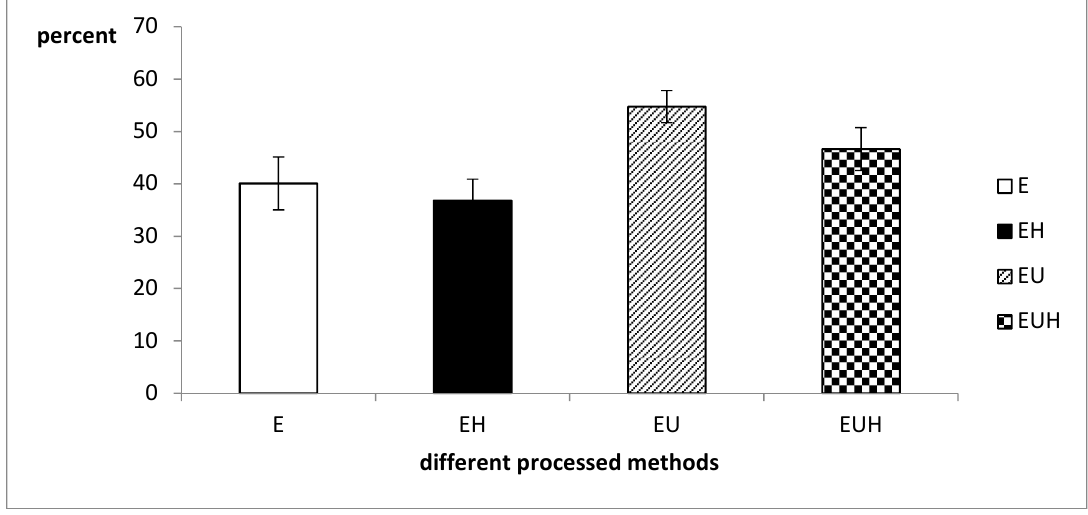
Figure 3. The absorption difference of total protein in different groups.